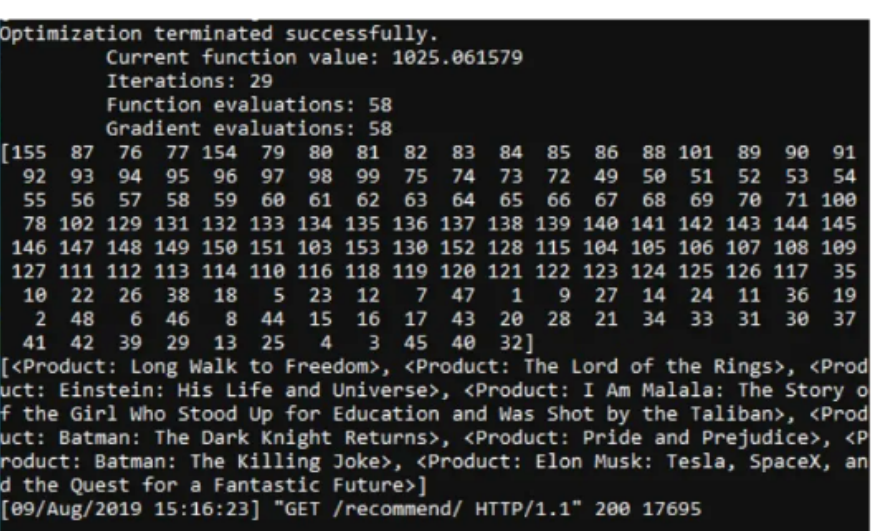
Figure 8. CNN-LSTM model output.